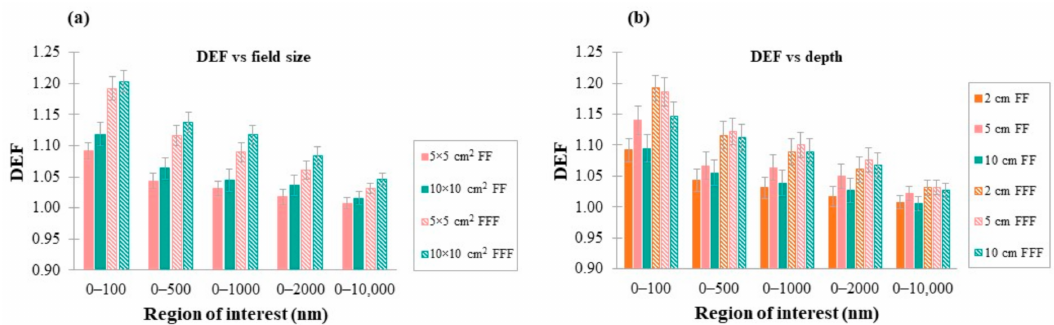
Figure 9. ( a ) Average DEF in regions of interest for two field sizes inside the mathematical water phantom. AuSlab was positioned at a depth of 2 cm inside the mathematical water phantom; ( b ) Average DEF in regions of interest for the different depths inside the mathematical water phantom. The size of AuSlab was 100 nm and the photon field used was 5 × 5 cm 2